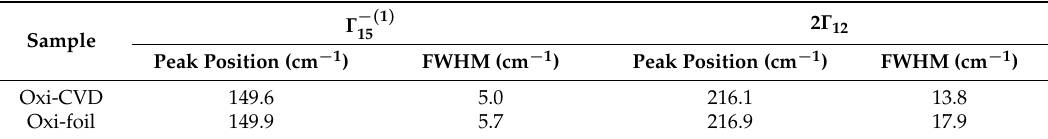
Figure 4. Raman spectroscopy of Cu foils after intentional oxidization in air. ( a ) Raman spectra of the Oxi-foil (red line) and the Oxi-CVD (blue line). The Raman spectrum of the Oxi-CVD was taken at the Cu surface uncovered by grapheme; ( b ) High resolution Raman spectra around the peaks of 150 and 217 cm − 1 . Vertical broken lines and cursors are eye guides to compare Raman peaks. Table 1. Comparison of Raman peaks in Figure